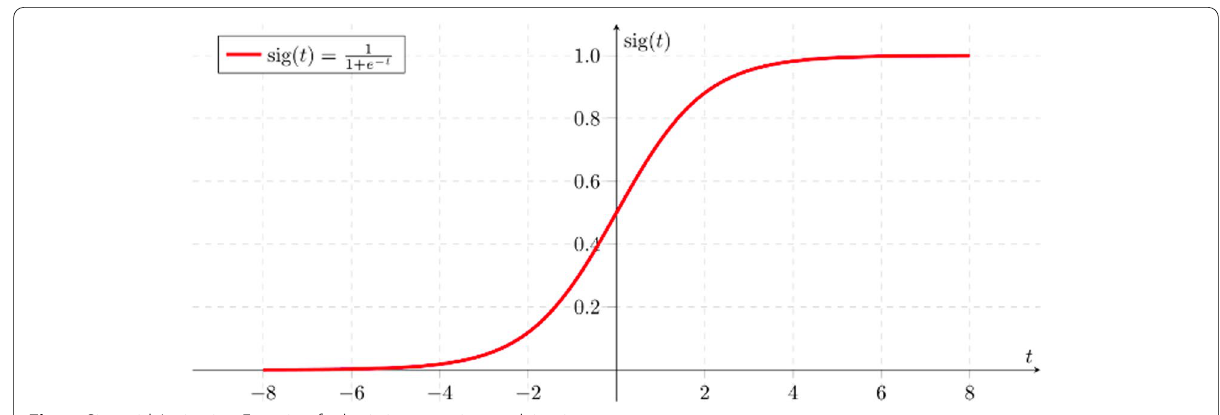
Fig. 7 Sigmoid Activation Function for logistic regression explaination